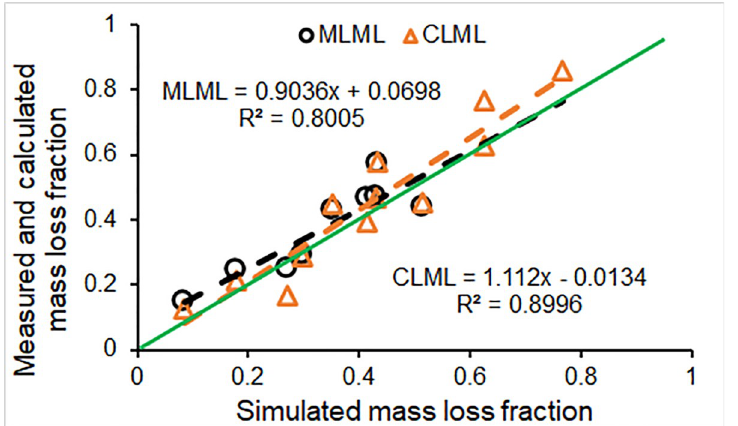
Fig 3. Results from model calibration: Comparing the simulated log mass loss fraction to the measured loss fraction in situ (MLML) and the calculated loss fraction based on the disk wood density loss (CLML); black dashed line, regressed relationship between the measured mass loss and the simulated loss; orange dashed line, regressed correlation between the calculated mass loss and the simulated loss; green line, 1:1. https://doi.org/10.1371/journal.pone.0254408.g003 the model to the study. Model validation against measured and calculated mass loss of logs from the FWDE were 1.01 and -4.63 for PBIAS, 0.40 and 0.50 for RRS, and 0.82 and 0.76 for R 2 (Fig 4; Table 4), respectively. These metrics were within acceptable ranges for the metrics [PBIAS 2 (-25.0, 25.0), RRS 2 (0.0, 0.7) and R 2 2 (0.0, 1.0)]. The simulated fraction of total mass loss (0.360) over the six-year simulation period was 1.0% lower than the MLML (0.364), but the simulated mass loss fraction (0.375) was approximately 4.6% higher than the CLML (0.359). The model performance efficiency (E) was 0.82 and 0.74 for the validation against the measured and calculated mass loss values, respectively; indicating that model performance was within the rating range of “Excellent” (E � 0.75) when validated against measured mass loss and within the range of “Good” when validated against calculated mass loss (E = 0.74, between 0.5 and 0.75).